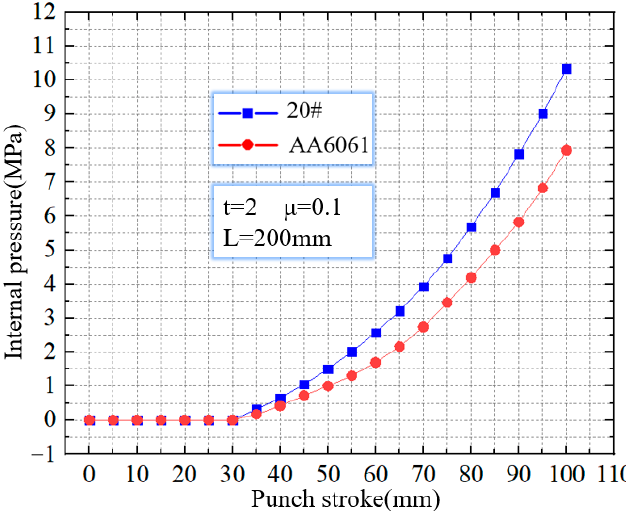
Figure 6. The critical wrinkling pressure of 20 steel and AA6061.